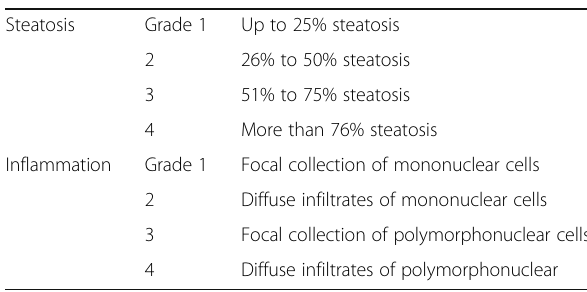
Table 1 Grade of NASH